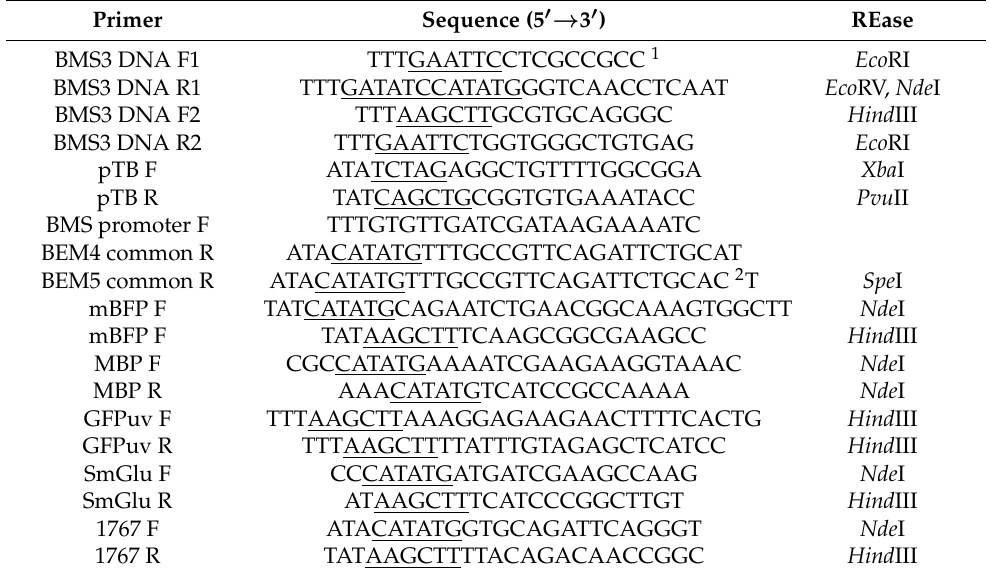
Table 1. List of primers used for amplification of several DNA sequences in this